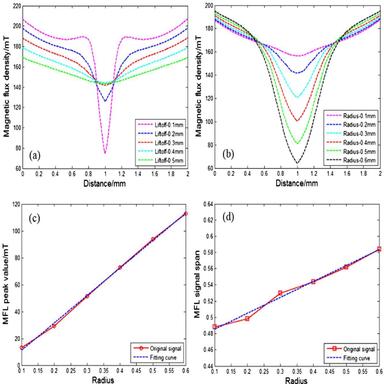
MFL signals and characterizations of arc-shaped defects; (a) MFL signals of arc-shaped defect in different liftoff values with the radius of 0.1 mm; (b) MFL signals of arc-shaped defects in different radiuses with the liftoff of 0.3 mm; (c) Relationships between MFL peak values in (b) and defect radiuses; (d) Relationships between MFL signal spans in (b) and defect radiuses.